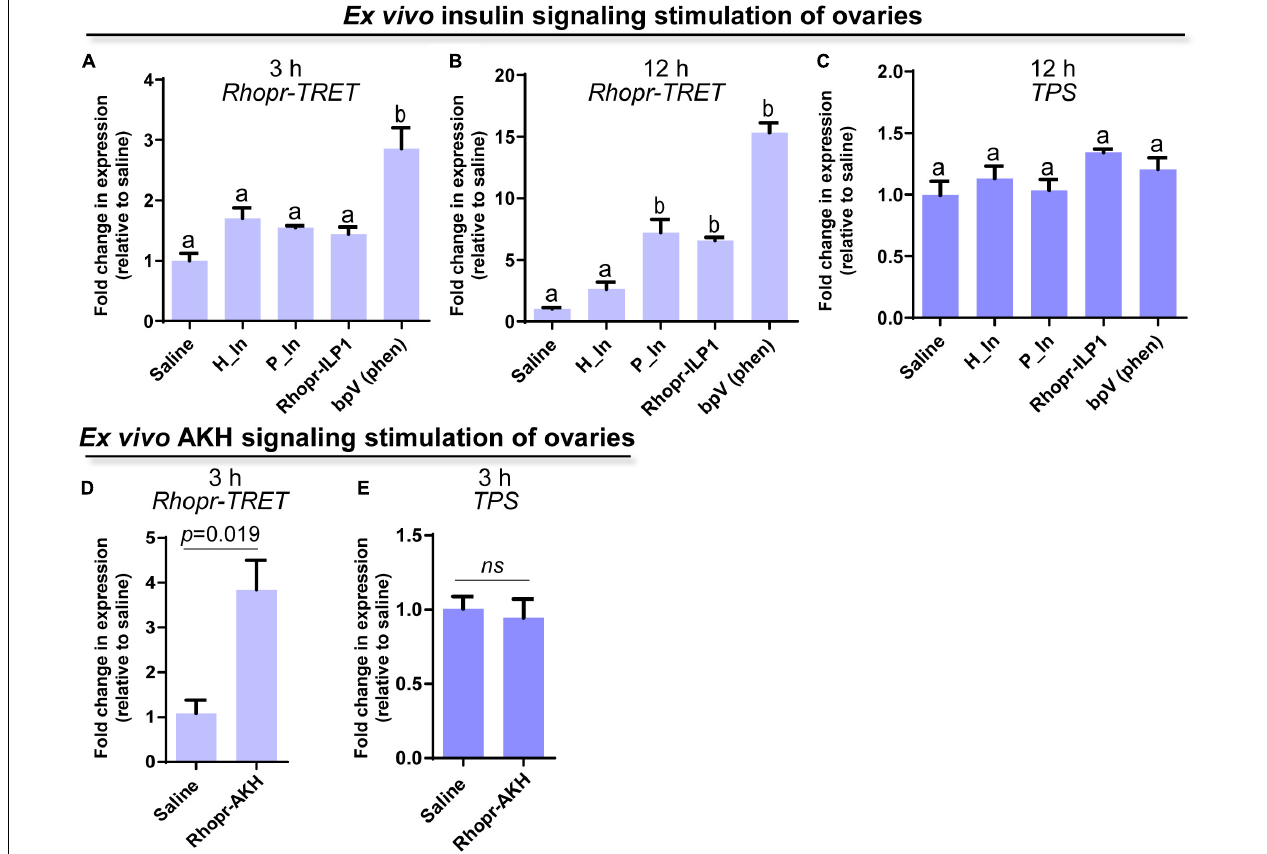
FIGURE 4 | Participation of insulin and AKH signaling in Rhopr-TRET mRNA expression using ex vivo assays. Ovaries from unfed adult females were incubated with human insulin (H_In), porcine insulin (P_In), R. prolixus ILP1 (Rhopr-ILP1), bpV (phen) or R. prolixus AKH (Rhopr-AKH). A control group of ovaries was incubated with only R. prolixus saline (saline). The effects of these stimulators on Rhopr-TRET and TPS transcript expression were tested by RT-qPCR. The y -axis represents the fold change in expression relative to control (saline, value ∼ 1). (A) Rhopr-TRET transcript expression after incubation with the insulin signaling activators for 3 h and (B) 12 h. (C) TPS transcript expression after incubation with the insulin signaling activators for 3 h. (D) Rhopr-TRET transcript expression after incubation with Rhopr-AKH for 3 h. (E) TPS transcript expression after incubation with Rhopr-AKH for 3 h. The results are shown as the mean ± SEM ( n = 3–4, where each n represents a pool of tissues from 2 insects). For (A–C) , statistically significant differences were determined by one-way ANOVA and Tukey’s test as post hoc test (different letters indicate significant difference at P < 0.05), and for (D,E) a Student’s t -test was